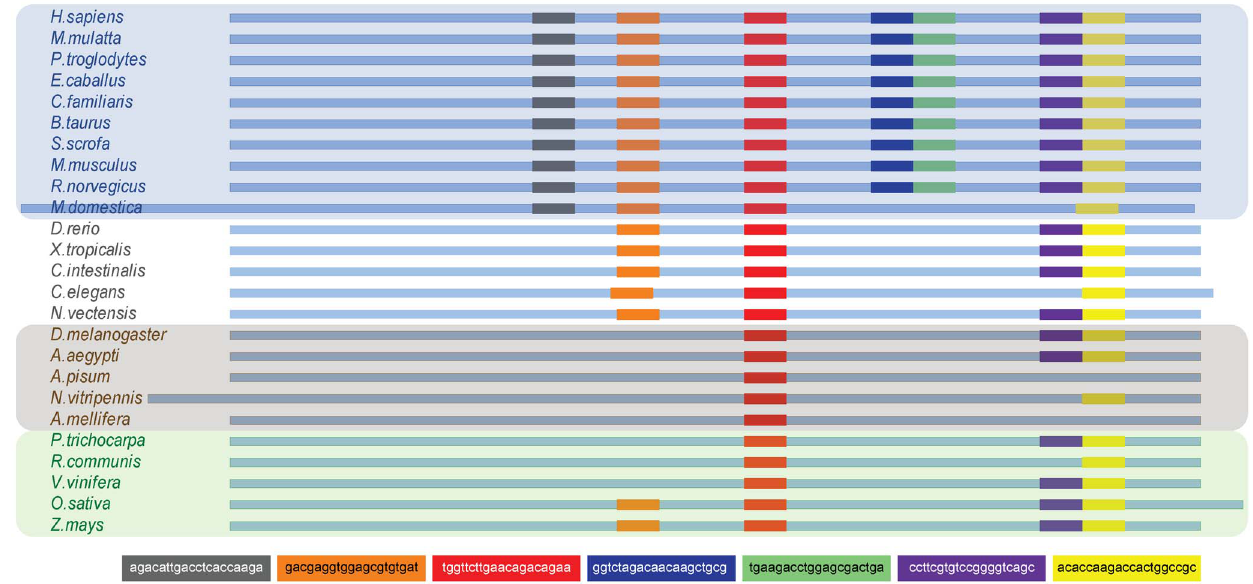
Figure 7. Schematic of the regions where selected entries of the signal dictionary were found in the different species.